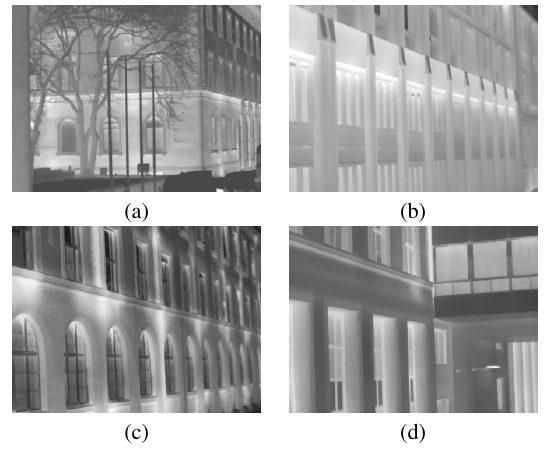
Figure 4. Overview over recorded scenarios with the SC3000 thermal infrared camera looking forward a) Several facades with different orientation and occlusions. b) Three building parts in the same facade plane but with different structure, the modern one with a repetitive pattern in the windows. c) Several small building parts in the same facade plane d) Several building parts